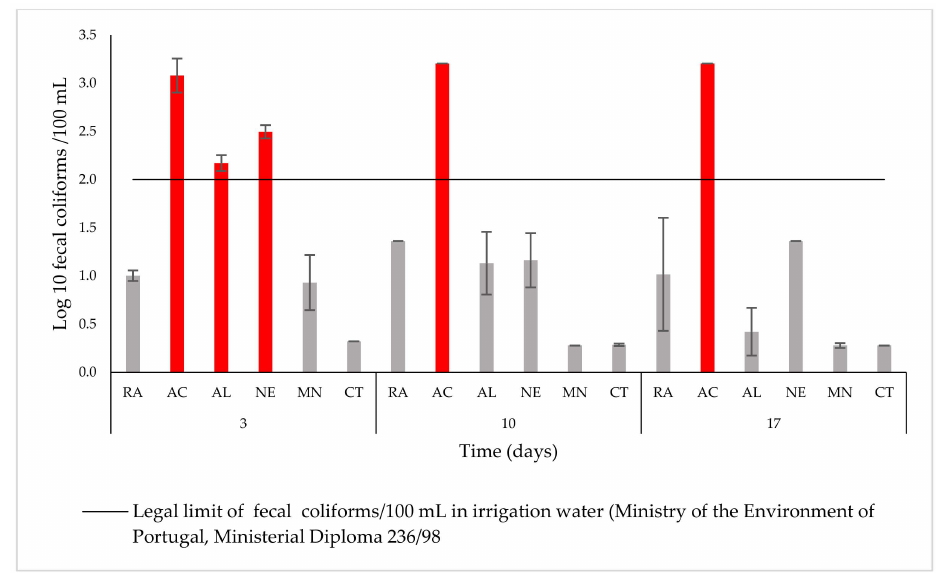
Figure 3. Log 10 of fecal coliforms per 100 mL of leachate collected after the first, second, and third IEs (corresponding to t = 3 d, t = 10 d, and t = 17 d after fertilizer application, respectively) for each treatment considered (RA = Raw dairy slurry; AC = Acidified dairy slurry; AL = Alkalinized dairy slurry; NE = Neutralized dairy slurry; MN = Mineral fertilizer; CT: Control) (mean values, n =